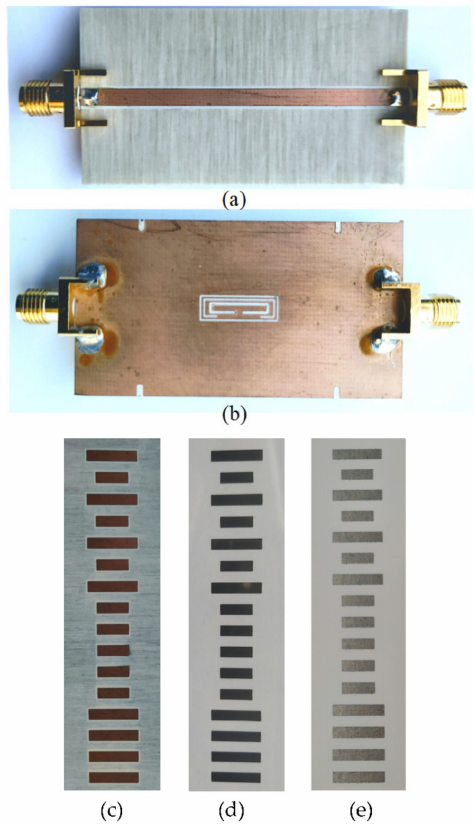
Figure 21. Photograph of the top ( a ) and bottom ( b ) view of the reader, implemented on the Rogers RO4003C with dielectric constant ε r = 3.38, thickness h = 0.81 mm and loss factor tan δ = 0.0022, and photograph of an encoder coded with the De Bruijn sequence and implemented in different substrates: ( c ) RO4003C with dielectric constant ε r = 3.38, thickness h = 0.2 mm and loss factor tan δ = 0.0022, ( d ) plastic substrate (polyethylene naphthalate, or also known as PEN , with a thickness h = 125 µ m, from Dupont ), and ( e ) paper substrate (powercoat XD with a thickness h = 200 µ m, from Arjowinngs). Reprinted with permission from [26]. Copyright 2020 IEEE.